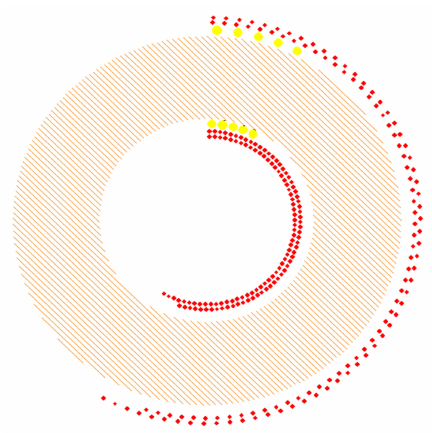
Figure 13. 2D toroidal transformer ( N P = 5 & N S =